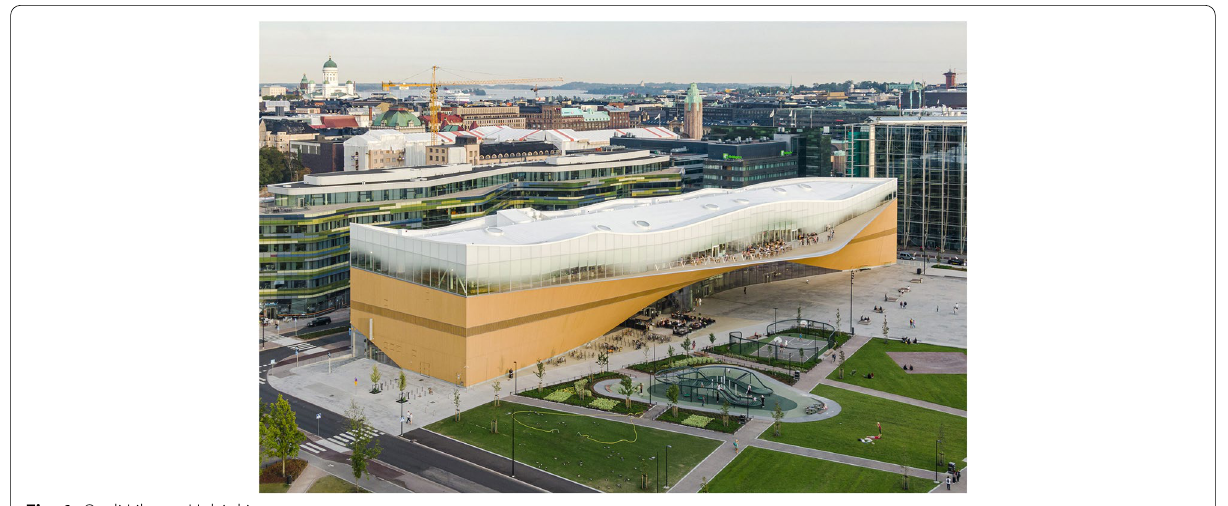
Fig. 1 Oodi Library, Helsinki